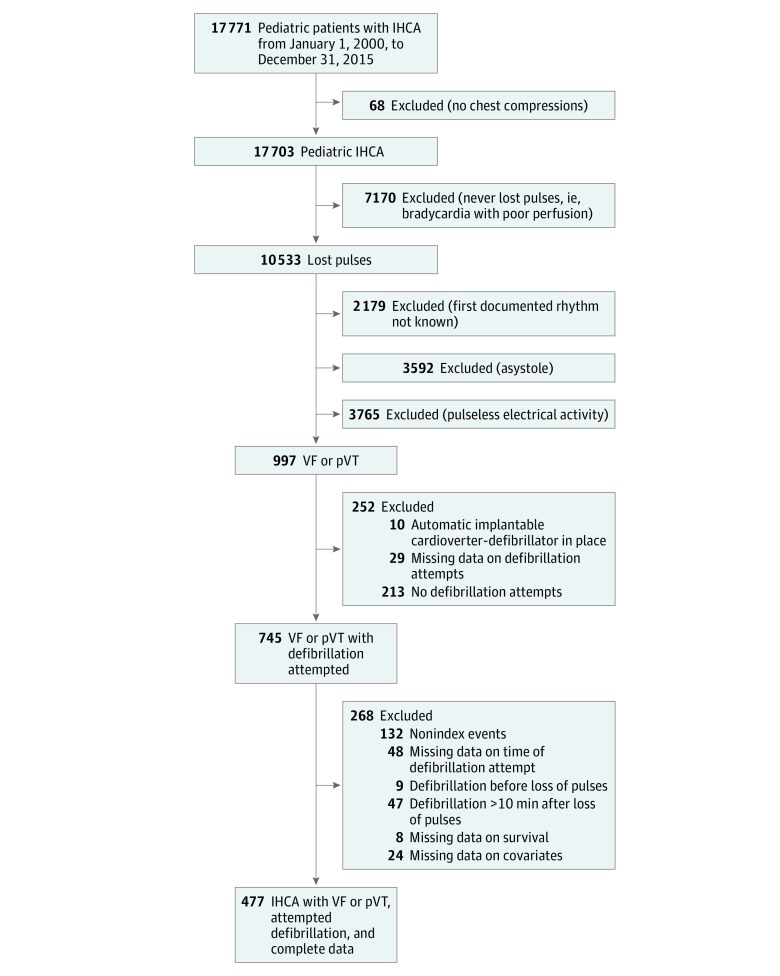
Patient Inclusion and Exclusion CriteriaOf 17 771 pediatric IHCA events, 477 were included in the study. IHCA indicates
in-hospital cardiac arrest; pVT, pulseless ventricular tachycardia; VF, ventricular
fibrillation.